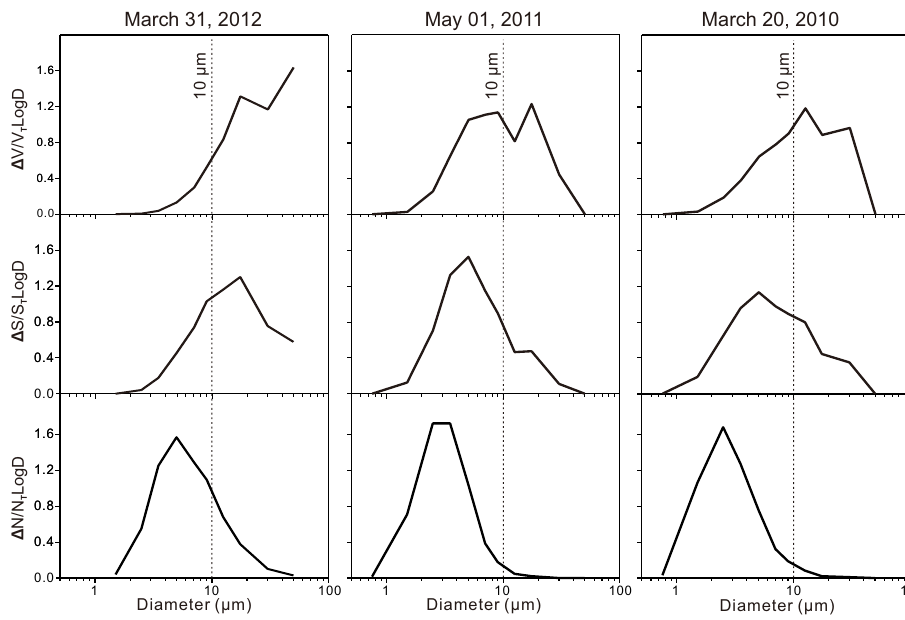
Fig. 3. Number, surface area, and volume–size distributions of three Asian dusts measured by scanning electron microscopy. Table 3. Particle number, surface area, and volume contributions of four size bins to major minerals in the Asian dust TSP collected on 31 March 2012 (unit in